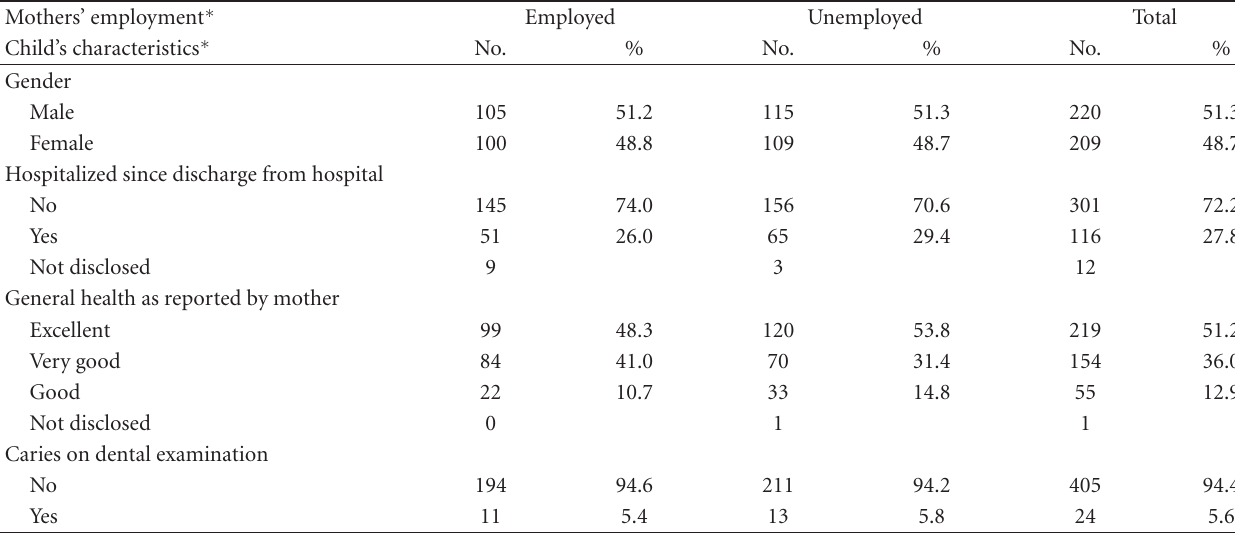
Table 4: Characteristics of the children.